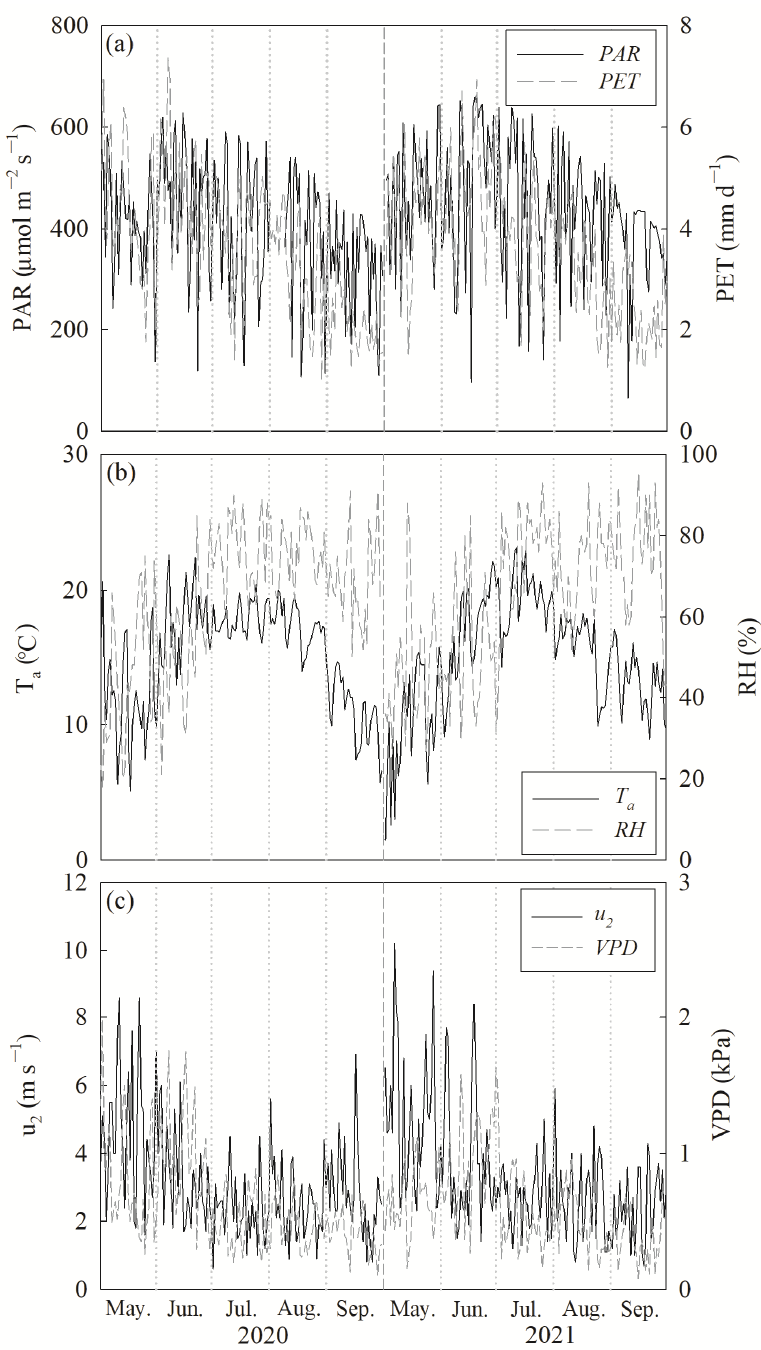
Figure 2. Daily variations in ( a ) photosynthetically active radiation ( PAR ) and daily potential evapotranspiration ( PET ), ( b ) temperature ( T a ) and relative humidity ( RH ), ( c ) wind speed ( u 2 ) and vapor pressure deficit ( VPD ).